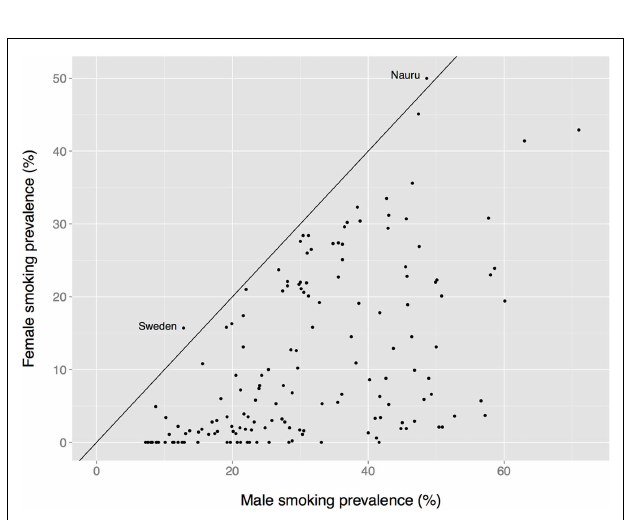
FIGURE 7 | Female vs. male smoking prevalence across nations .The solid diagonal line represents equal prevalence.Values coded as “ < 1%” set to 0. Data from theTobacco Atlas